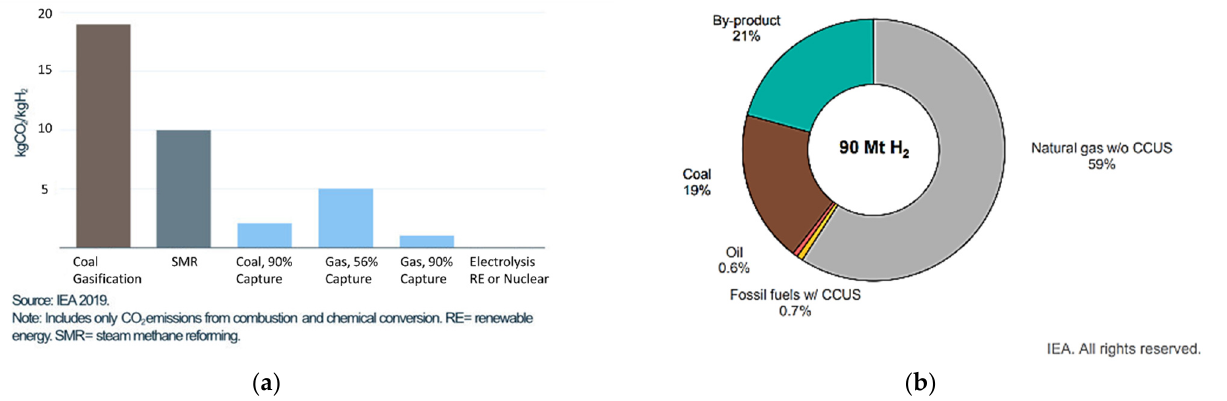
Figure 8. ( a ) Hydrogen production methods by their source-based emissions and capture of CO 2 emissions from combustion and chemical conversion, ( b ) the source of hydrogen produced in Europe, 2019. Reprinted with permission [55].